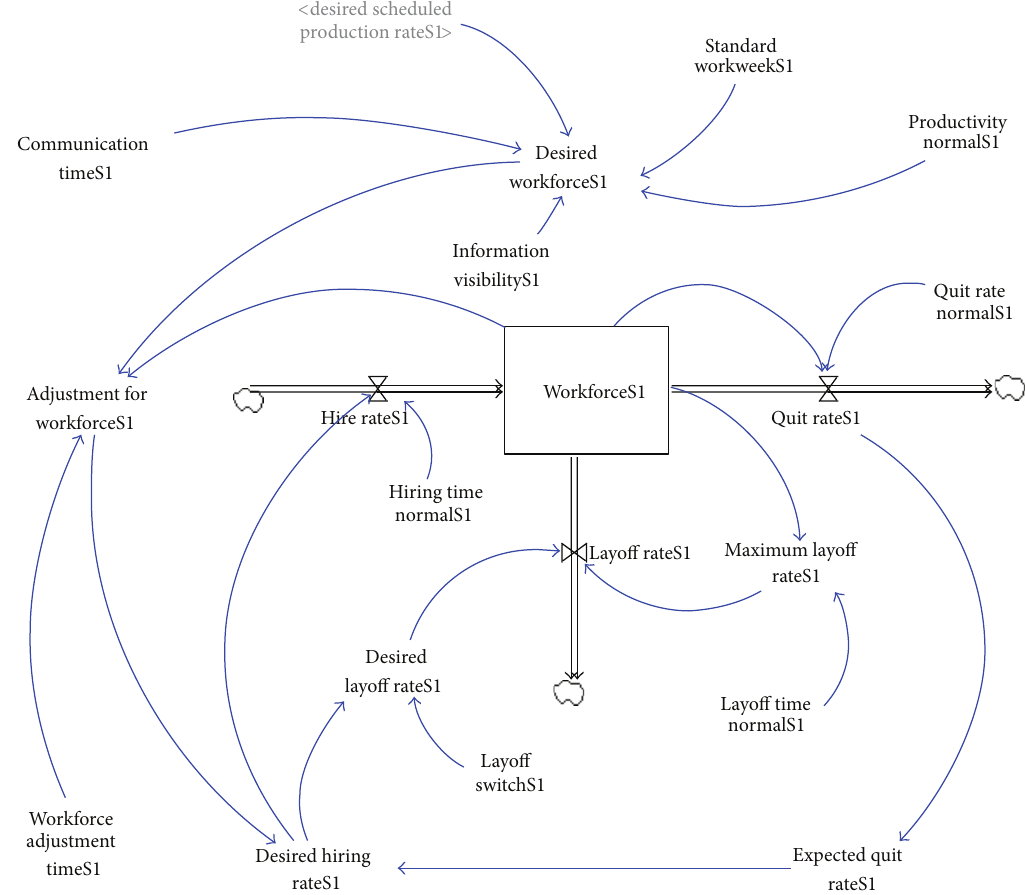
Figure 3: Workforce view of the supplier